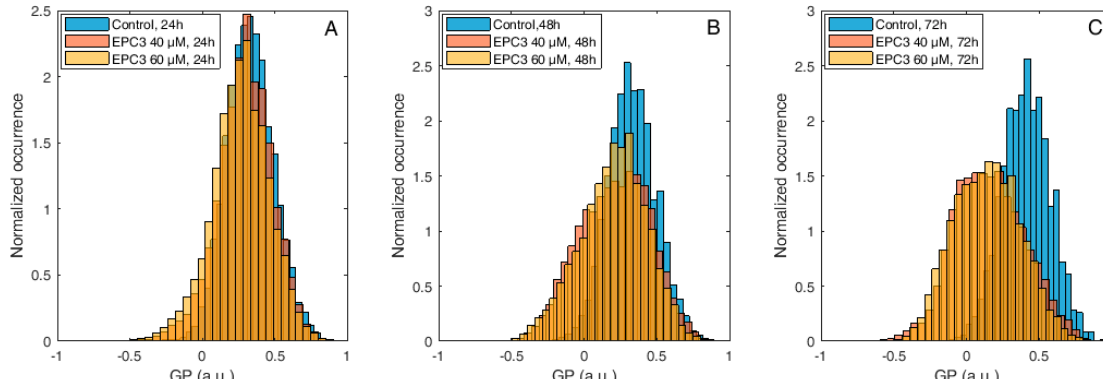
Figure 4. Di-4-ANEPPDQH GP values measured at the PM of MCF-7 cells after EPC3 treatment. Normalized histograms of GP values measured in pixels belonging to the PM of MCF-7 cells labeled with Di-4-ANEPPDQH. Cells were treated with 40 µ M (orange bars) or 60 µ M (yellow bars) EPC3. GP values measured in cells not treated with EPC3 are shown as blue bars. Fluorescence intensity values were acquired 24 h ( A ), 48 h ( B ), and 72 h ( C ) after the addition of EPC3. For each condition, GP values were pooled from ca. 50 ROIs selected at the PM of distinct cells, in two independent experiments. The total number of calculated GP values (and measured pixels) for each experimental condition was between ca. 10,000 and 30,000. Measurements were performed at RT. Representative images of treated cells and ROIs are shown in Figures S1 and S4.